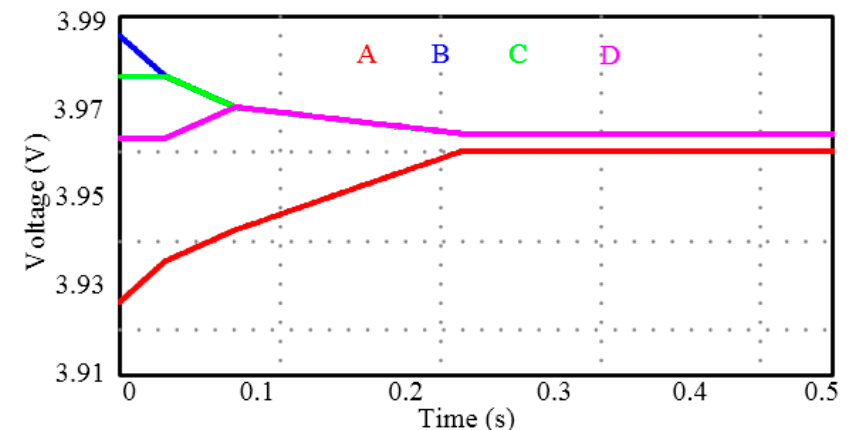
Energies 2018 , 11 , x FOR PEER REVIEW Figure 12. Four cells’ voltage trajectories in simulation. Figure 12. Four cells’ voltage trajectories in simulation.